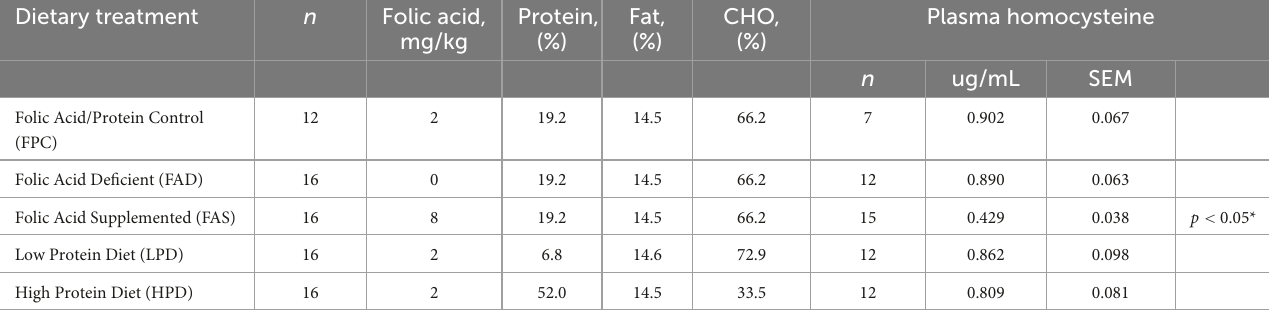
TABLE 1 Concentration of folic acid (mg/kg) and percent protein in five different dietary treatments provided ad libitum to C57BL/6J mice (The Jackson Laboratory, #000664) for 8 weeks and the concentration of plasma homocysteine (ug/mL). Dietary